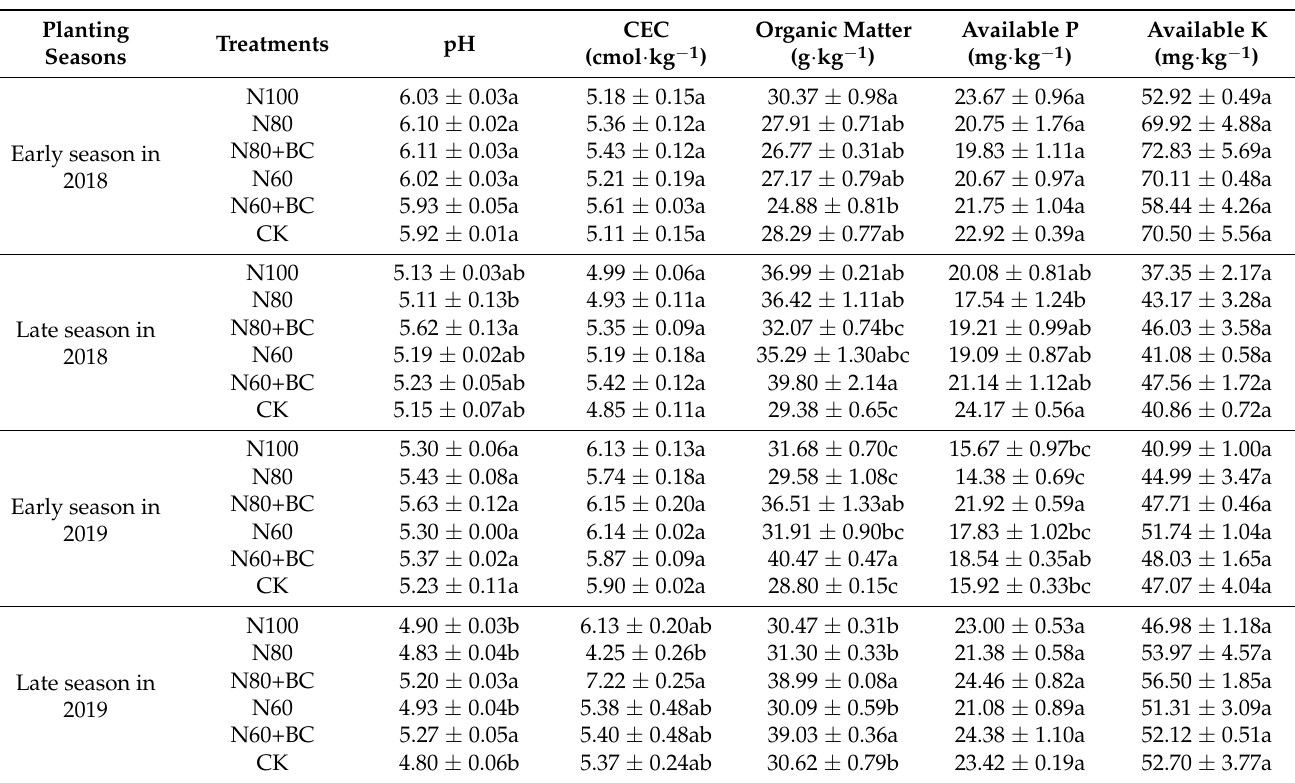
Table 2. Effects of N fertilizer reduction combined with biochar application on soil pH, CEC, organic matter, available P, and available